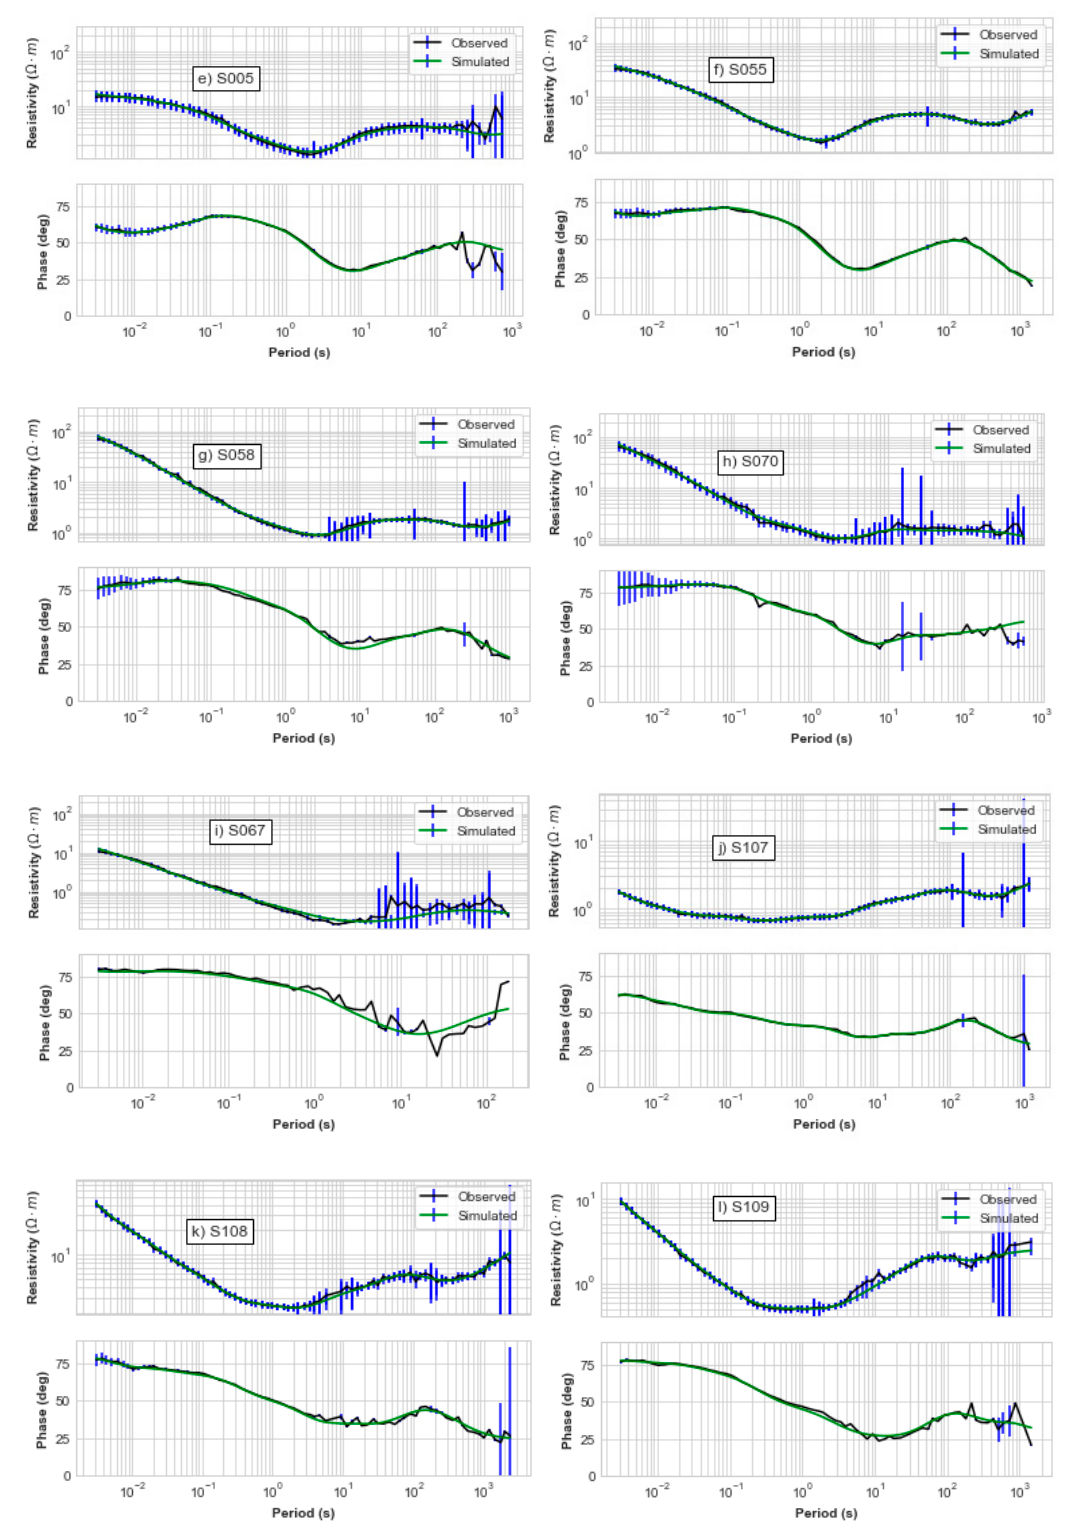
Figure 3. Comparison of observed and simulated electrical resistivity at MT sites along 2D MT profile in Figure 1.